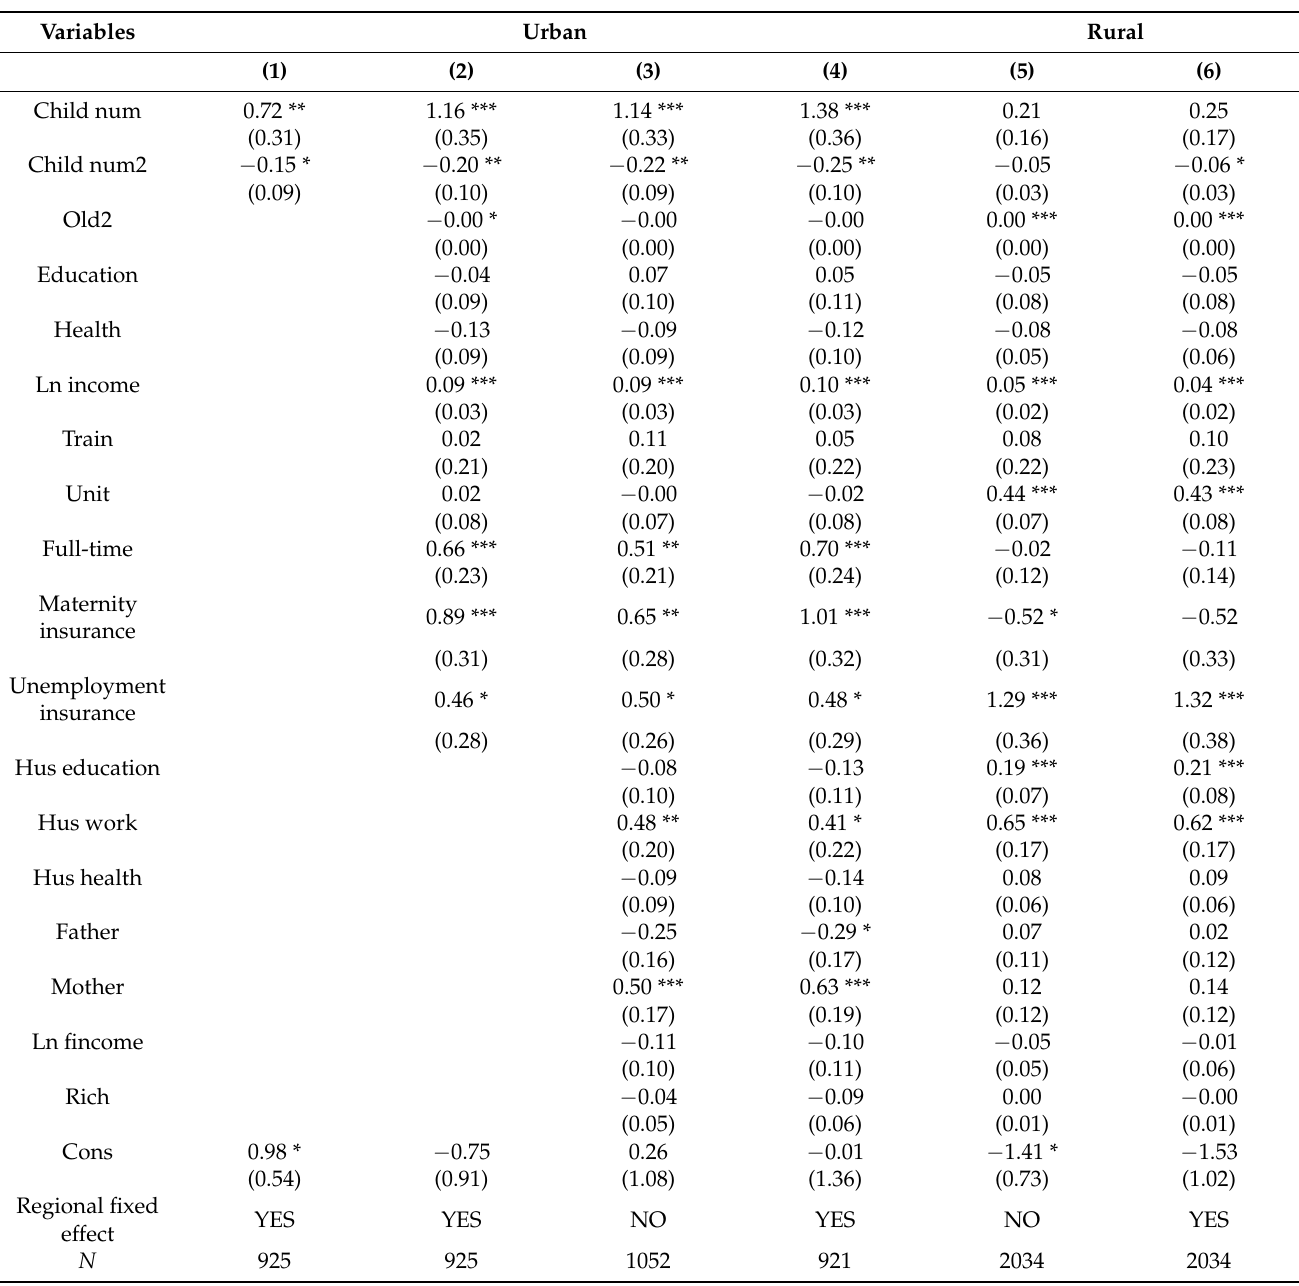
Table 9. Heterogeneity test: urban–rural heterogeneity.